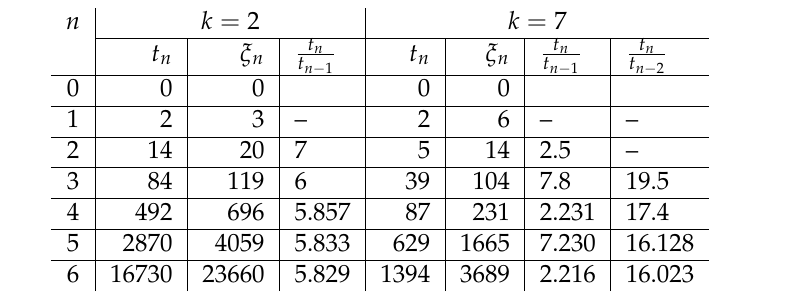
Table 2. Solutions of (1) for k =